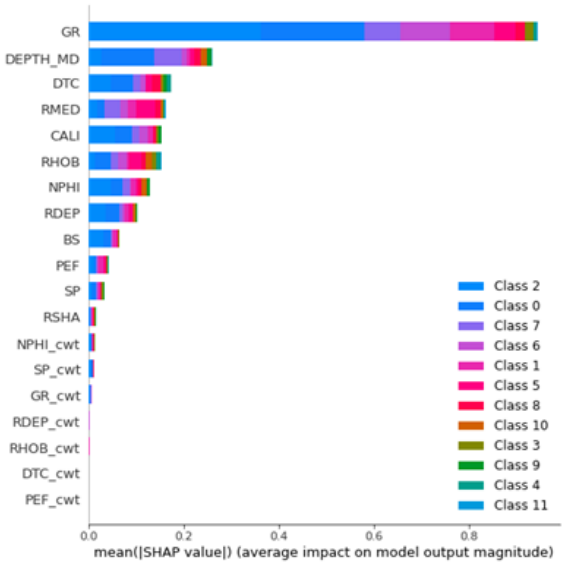
Figure 6. Importance factor of each input variable for the